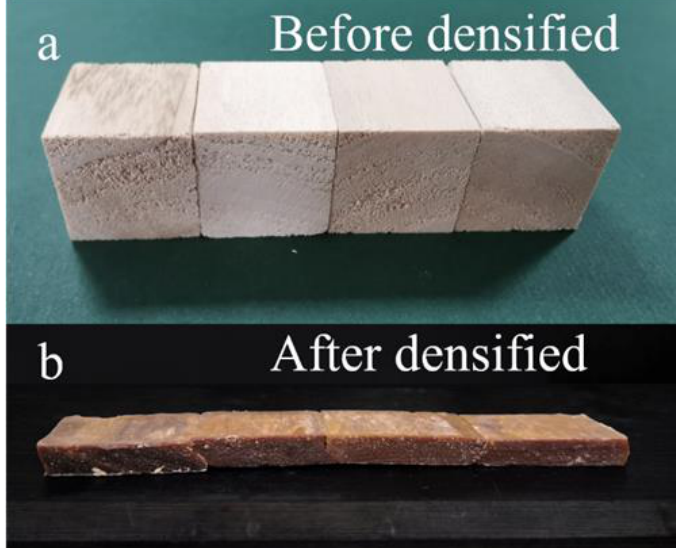
Figure 1. Comparison of the morphological characteristics of the appearance in one of the groups by PEG impregnation for delignification of pristine wood ( a ) and densified wood ( b ).